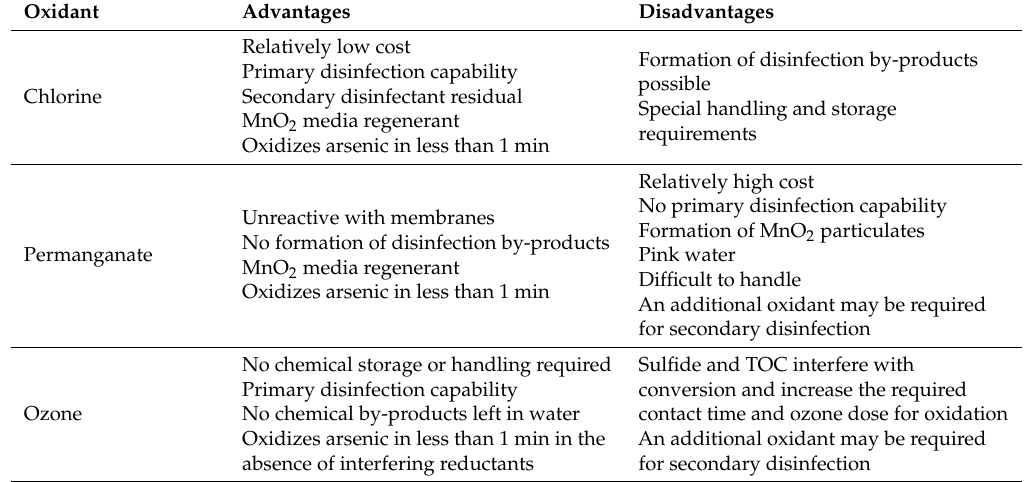
Table 1. Comparison of different oxidants applied for arsenic removal (adapted from